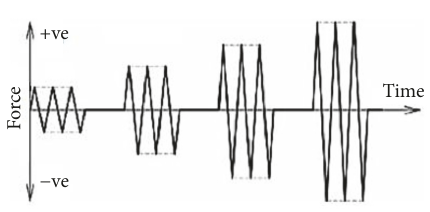
Figure 5: The pattern of quasistatic loading protocol.